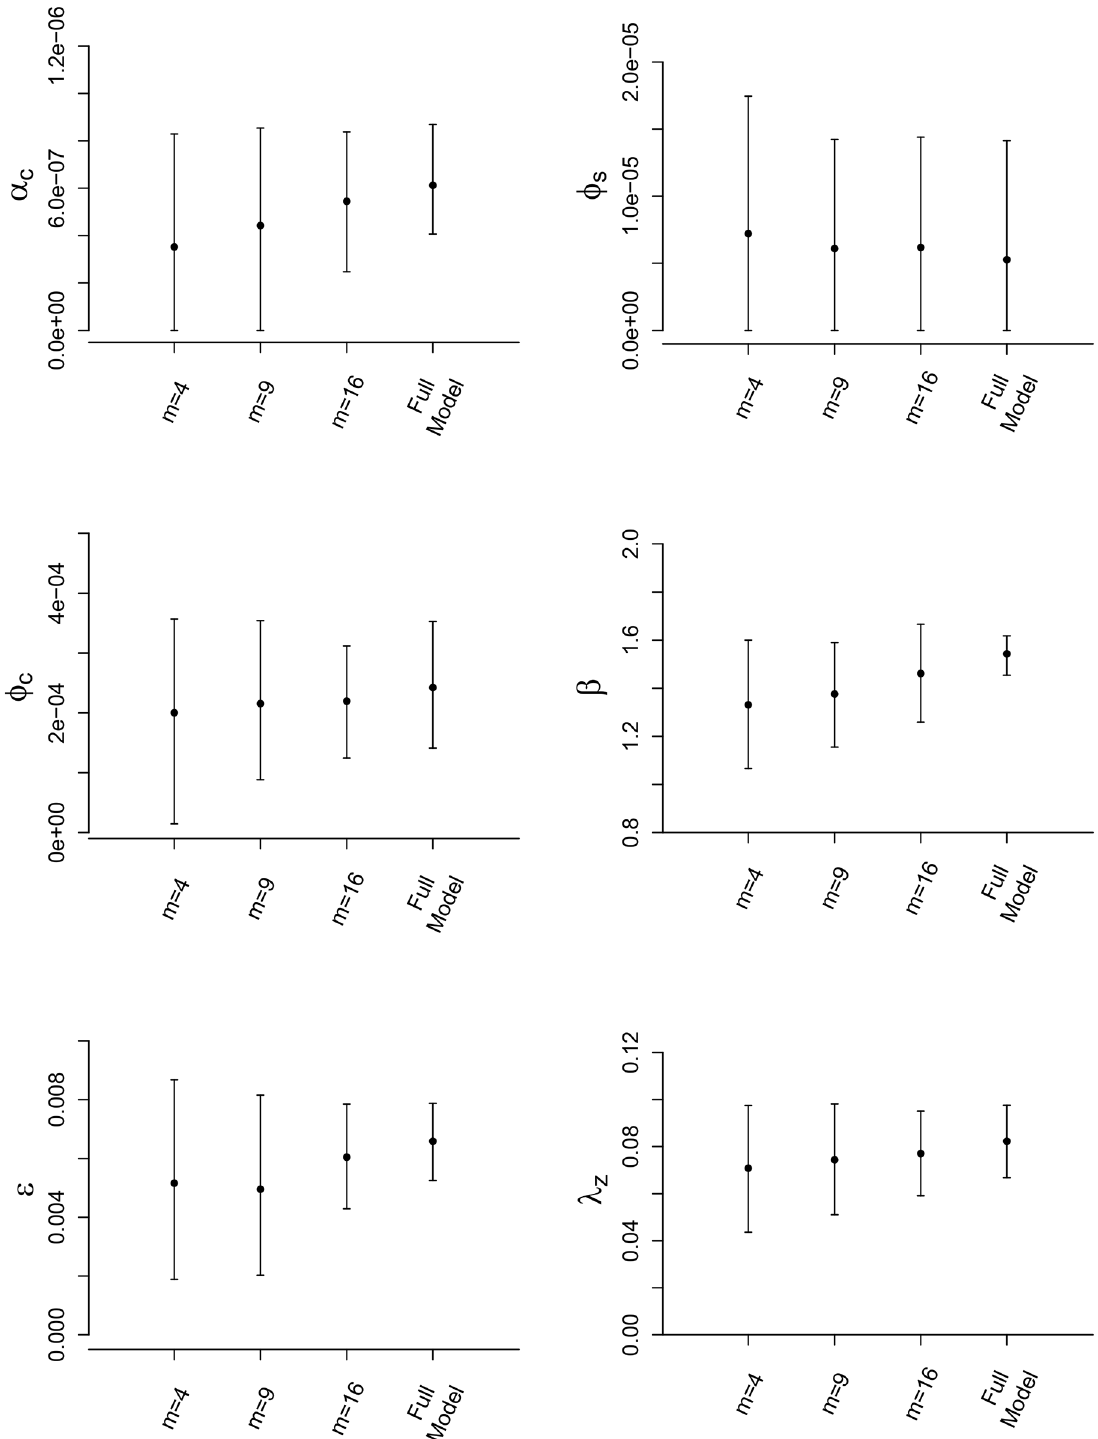
Fig 5. Posterior results for FMD-ILM using the spatial stratification method. Posterior means and 95% credible intervals for all parameters of the data augmented FMD-ILM under the spatial stratification method. We sampled ρ = 0.50 from each stratum. The results are compared to the full model.